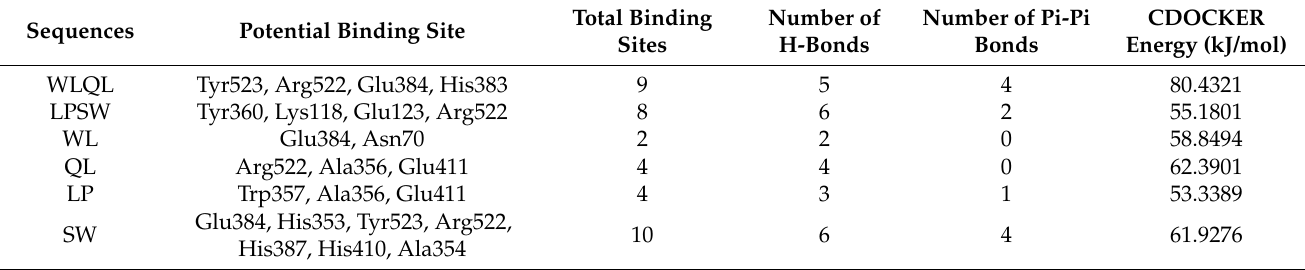
Table 3. Potential binding sites of ACE inhibitory peptides based on molecular docking analysis.